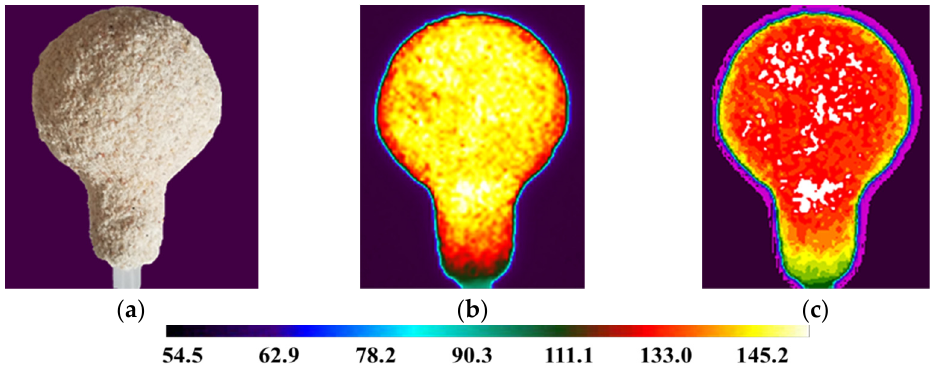
Figure 12. M2 sample ( a ); sample thermogram M2 obtained directly from the camera ( b ); defectogram of M2 sample with a temperature map scale ( c ).